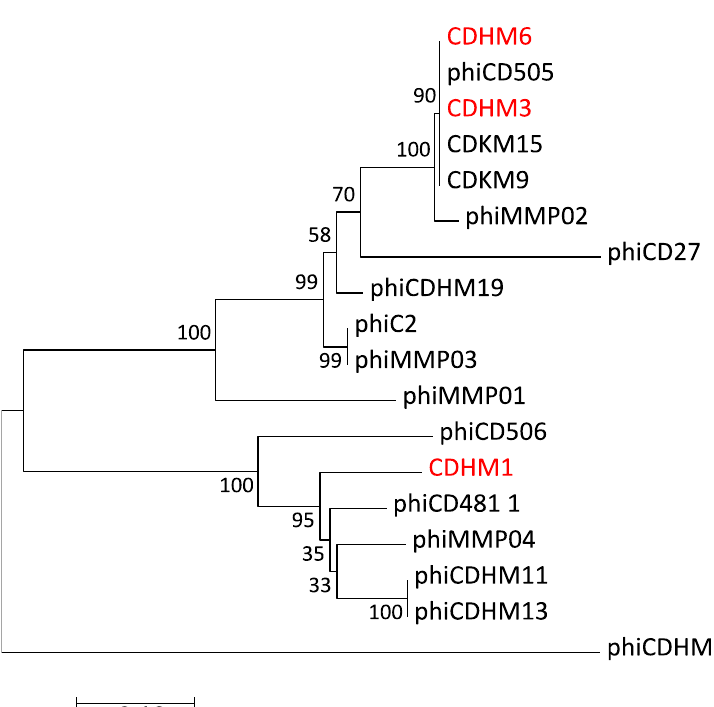
Figure 3. Evolutionary relationship of putative tail fiber proteins of C. difficile phages was constructed using the Neighbor-Joining method. The bootstrap consensus tree was inferred from 500 replicates was taken to represent the evolutionary history of C. difficile phage putative tail fiber proteins and bootstrap values are shown next to the branches. The tree is drawn to scale and the scale bar represents the relative genetic distances. The evolutionary distances were computed using the p-distance method. All positions that contained gaps and missing data were eliminated from the analysis. The analysis involved 18 protein sequences, which included 15 annotated C. difficile myovirus tail fiber proteins available on NCBI (listed in Supplementary Table S1) and myovirus CDHM1, CDHM3 and CDHM6 from the present study (highlighted in red). Evolutionary analyses were conducted in MEGA7.